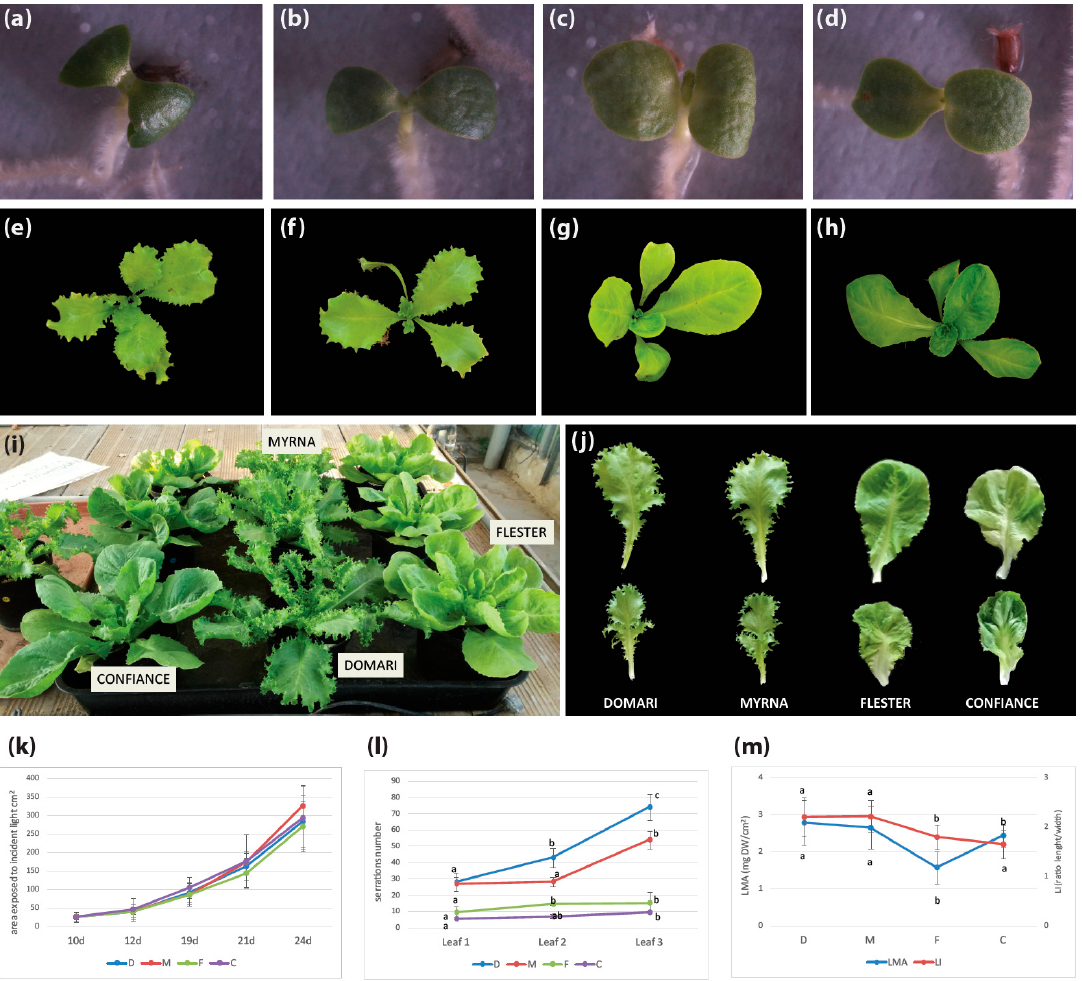
Figure 5. Morphological analysis of C. endivia endives, ‘Domari’ ( a , e , i , j ) and ‘Myrna’ ( b , f , i , j ), and escaroles, ‘Flester’ ( c , g , i , j ) and ‘Confiance’ ( d , h , i , j ). ( a – d ) Cotyledonary stage, ( e – h ) 20-day-old plantlets, ( i ) 40-day-old endive and escarole plants, ( j ) 20th leaf of 50 days mature endive and escarole plants, and ( k ) plant area exposed to incident light in 10- to 24-day-old endive and escarole plantlets (mean ± SD, n = 6). Means with di ff erent letters represent significant di ff erence at p < 0.05. ( l ) Number of serrations on the first, second, and third leaves in endives and escarole 21-day-old plantlets (mean ± SD, n = 6). Means with di ff erent letters represent significant di ff erence at p < 0.05. ( m ) Ratio of leaf dry mass to leaf area (LMA) and ratio of leaf length to leaf width (LI) in fully expanded leaves of 50-day-old endive and escarole plants (mean ± SD, n = 6). D, Domari; M, Myrna; F, Flester; C, Confiance.